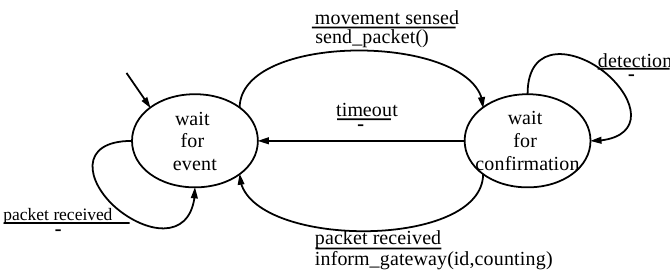
Figure 4. FSM diagram for each sensor node of dual implementation.